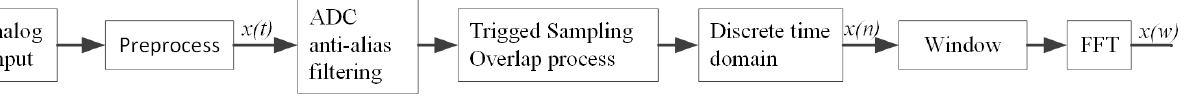
Figure 6. The time domain acquisition and frequency domain transform process.